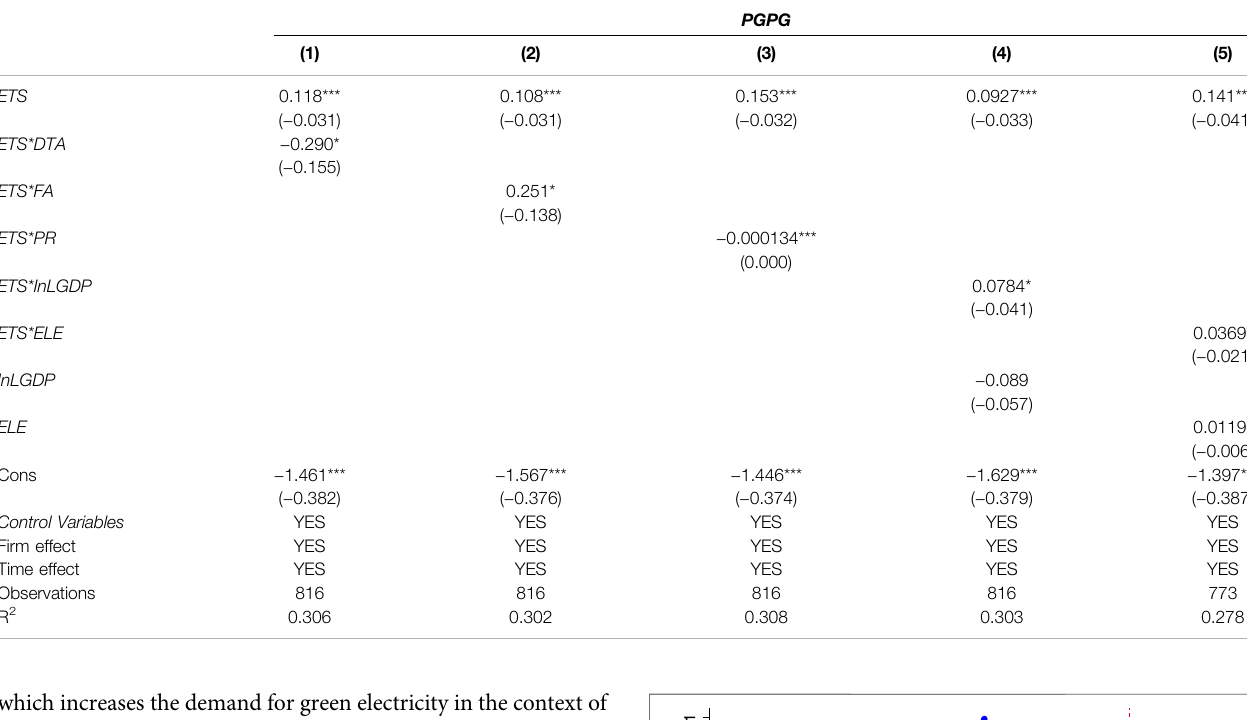
TABLE 5 | The heterogeneity test results.